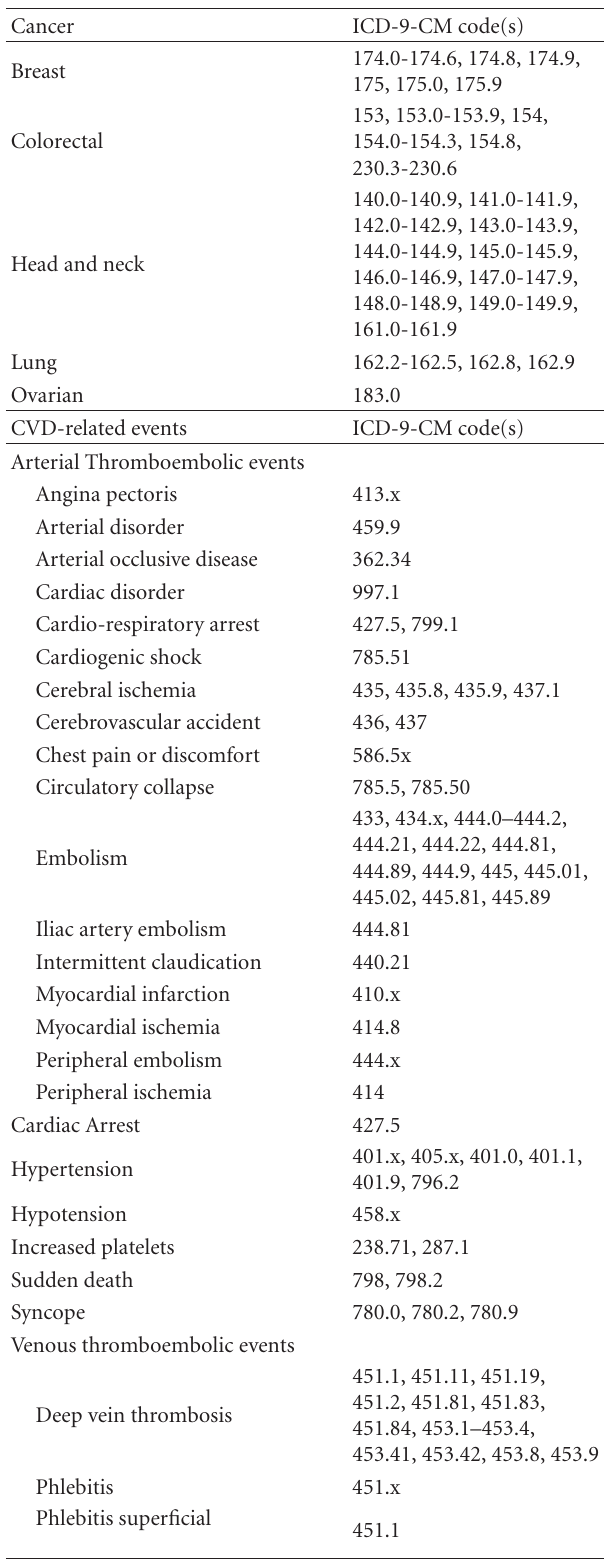
Table 4: ICD-9 codes for selected cancers and cardiovascular-relat- ed